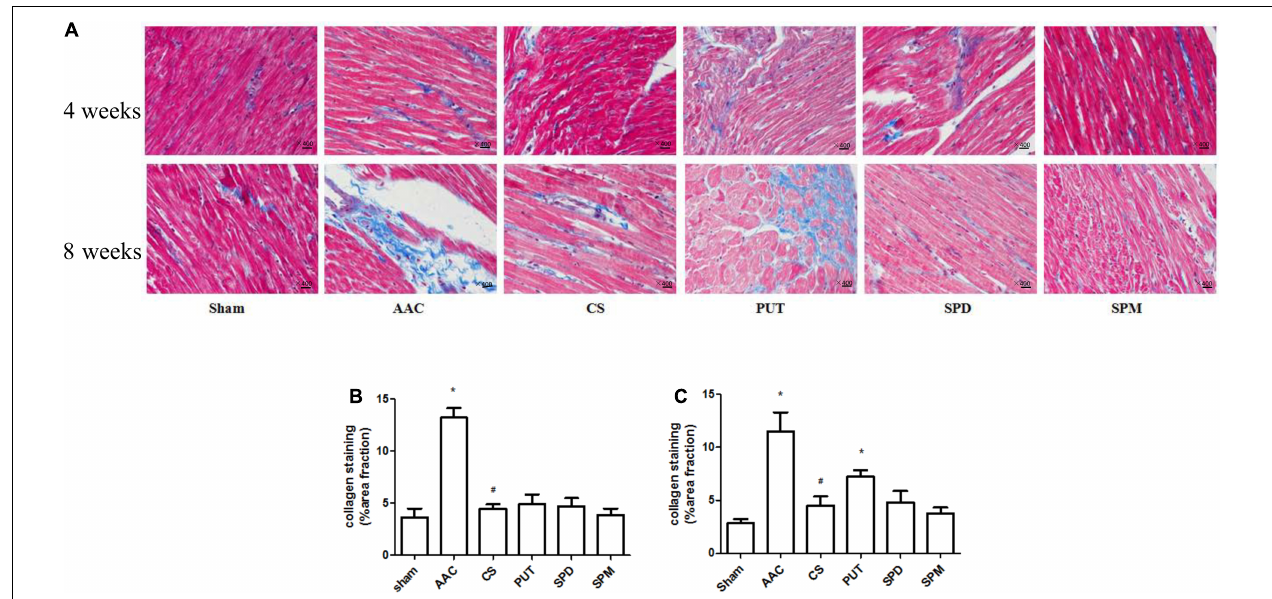
FIGURE 3 | Collagen deposition in cardiac tissue. (A) Representative images of collagen staining (400 × magnification). Heart sections stained with Masson’s trichrome; collagen is stained blue. AAC, abdominal aortic constriction; CS, cromolyn sodium; PUT, putrescine; SPM, spermine, SPD, spermidine. (B,C) Statistical analysis of collagen deposition after 4 weeks (B) and 8 weeks (C) of treatment with polyamines. * P < 0.05 vs sham group; # P < 0.05 vs AAC group. n = 8 per group. Scale bars, 100 µ